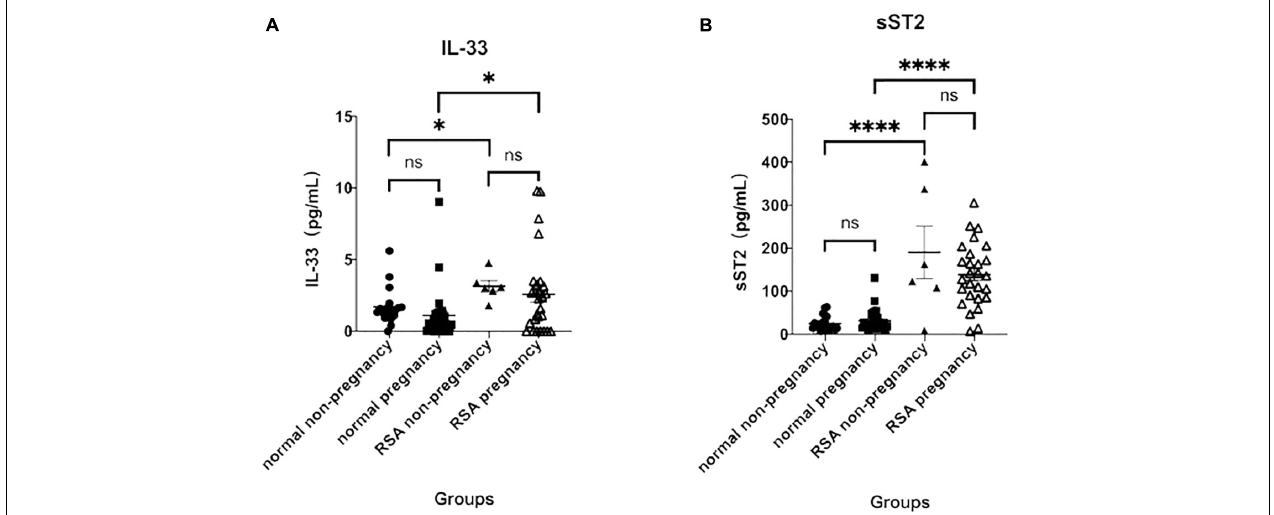
FIGURE 1 | Serum IL-33 and ST2 levels at 7–19 weeks of gestation. (A) Analysis of serum IL- 33 in the normal non-pregnancy, normal pregnancy, RSA non-pregnancy and RSA pregnancy groups. (B) Analysis of soluble ST2 in the same groups. ( ∗ p < 0.05 versus normal pregnancy group; ∗∗∗∗ p < 0.0001 versus normal pregnancy